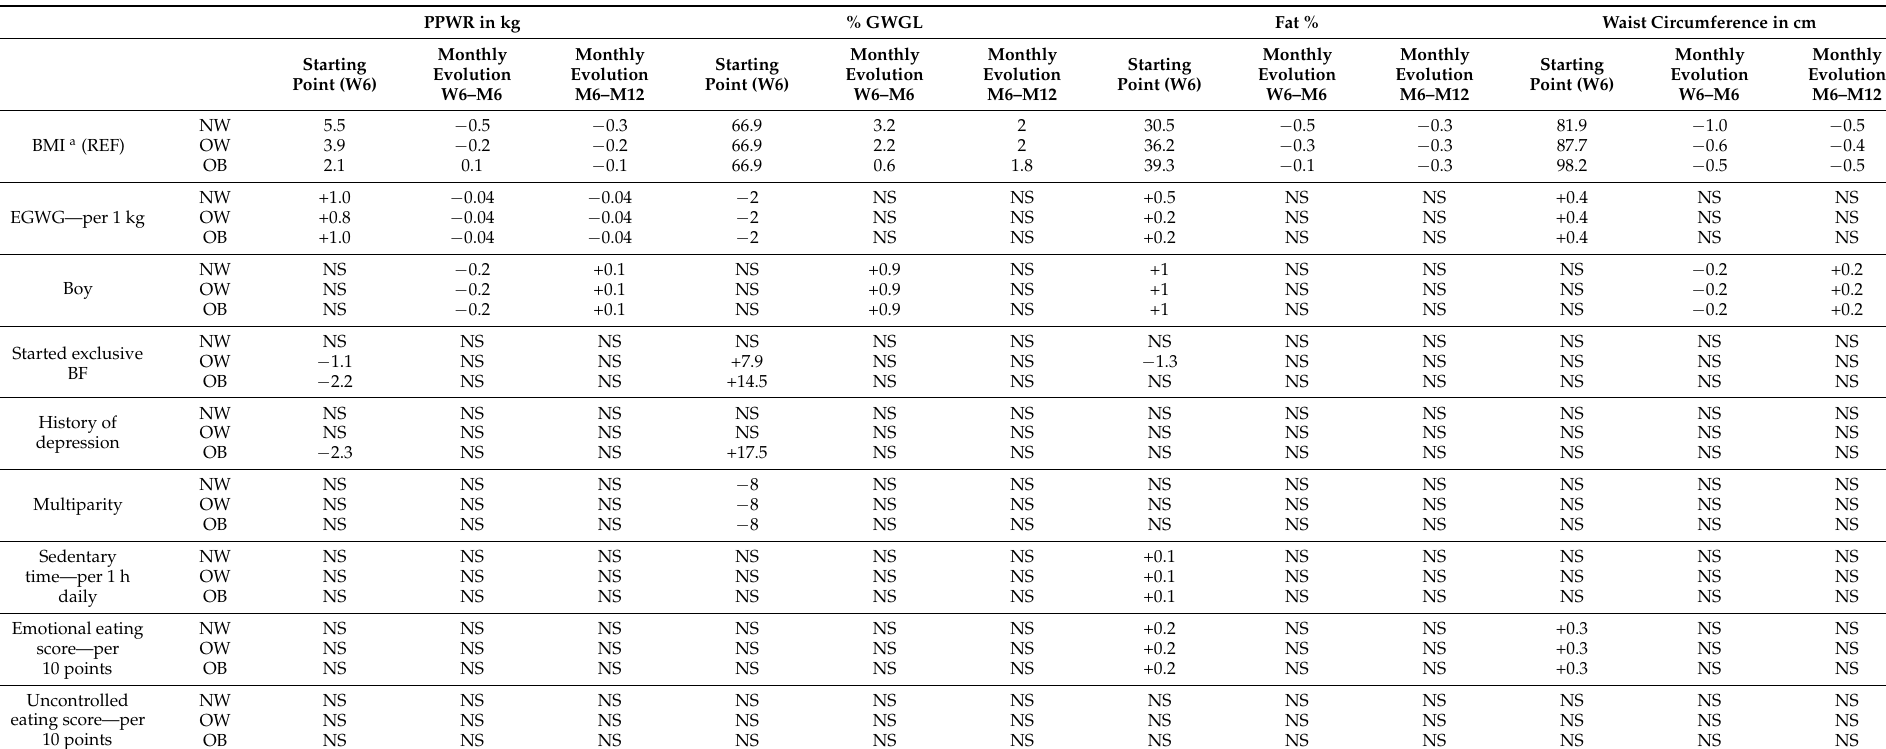
Table 3. Factors at six weeks postpartum in association with evolution of weight and body composition up to 12 months postpartum (N = 524 at 6 weeks, N = 395 at 6 months, N = 311 at 12 months